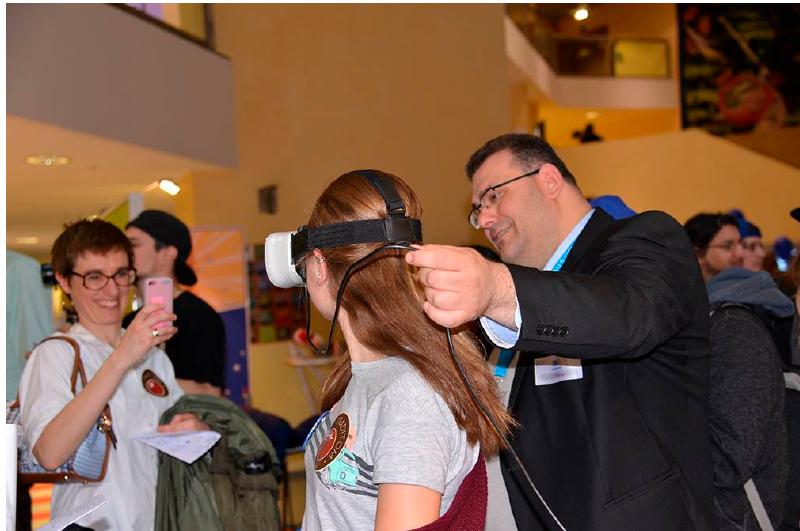
Figure 4. The content was presented during the Europe Day 2017 in Brussels. The event has been used as test and verification field for the immersion capabilities of the systems presented above, due to the availability of large and differentiated audience of families with young children (photo courtesy of European